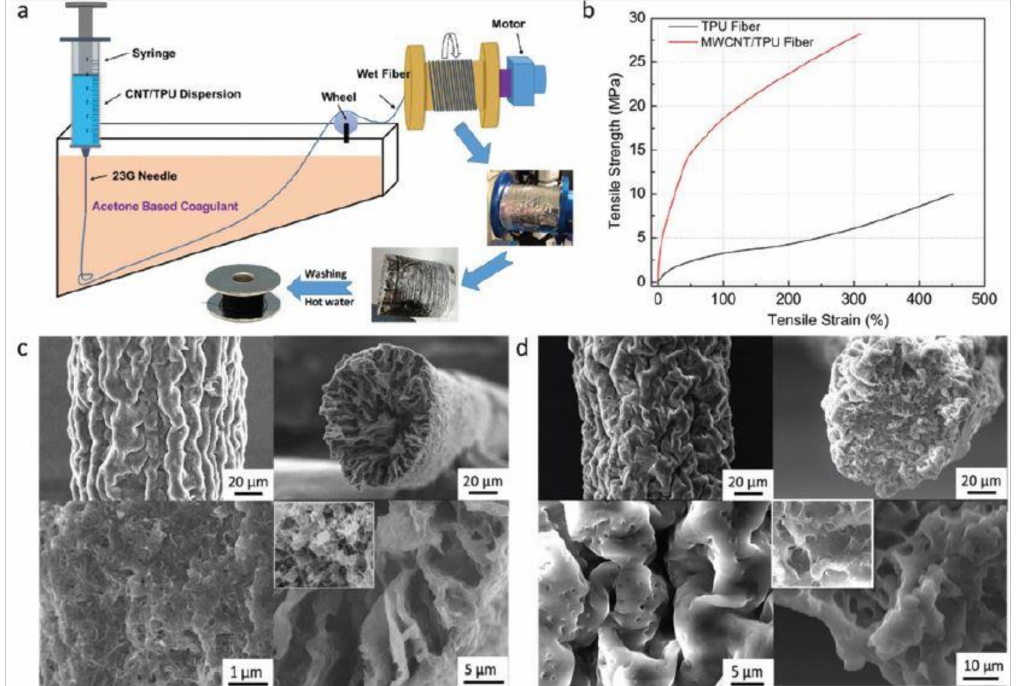
Figure 5. ( a ) Schematic diagram of the wet spinning process of the MWCNT-based composites. ( b ) Stress–strain curve of the composites. ( c , d ) SEM images of the composite fibers [91]. Reproduced from He, Z.; Zhou, G.; Byun, J.H.; Lee, S.K.; Um, M.K.; Park, B.; Kim, T.; Lee, S.B.; Chou, T.W. Highly stretchable multi-walled carbon nanotube/thermoplastic polyurethane composite fibers for ultrasensitive, wearable strain sensors. Nanoscale 2019 , 11 ,